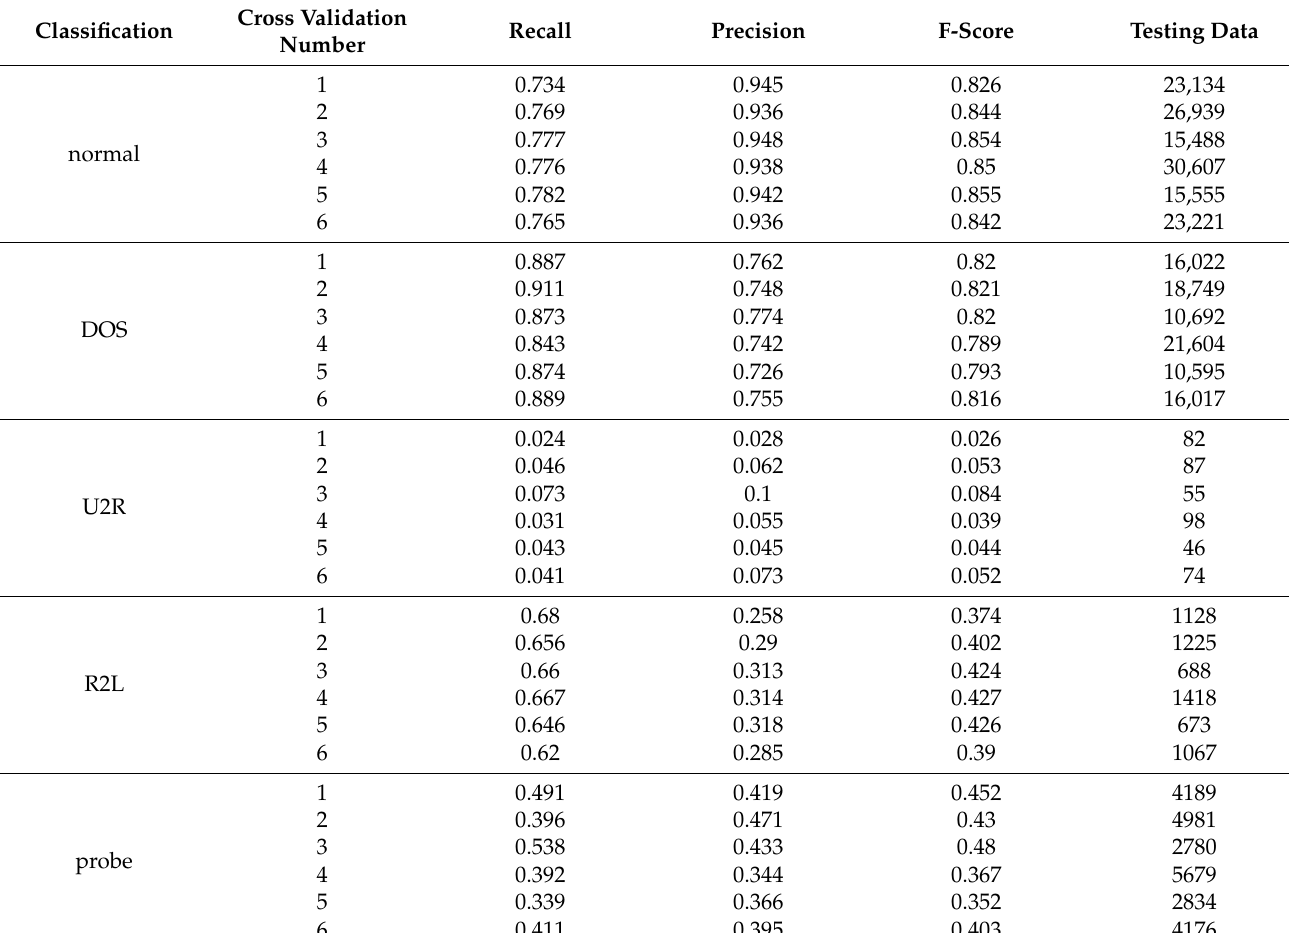
Table 5. The results of 6 cross-validation